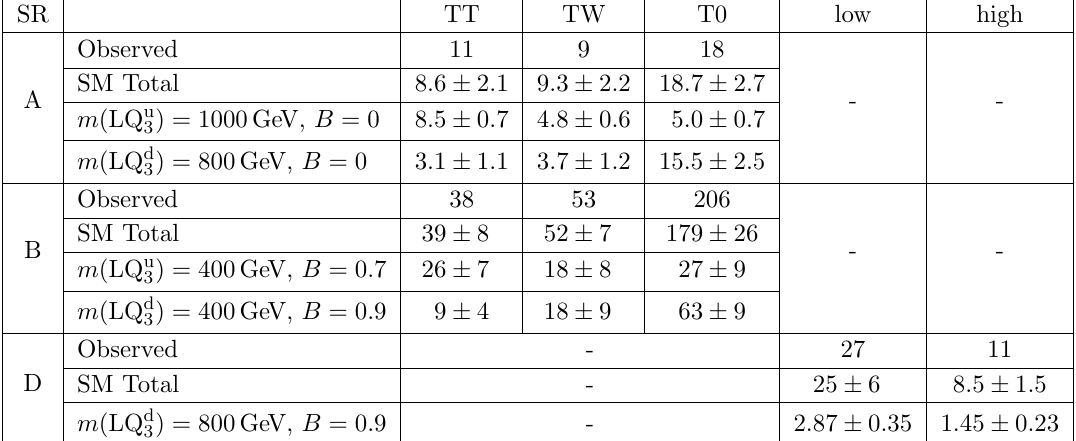
Events are classi(cid:12)ed according to the decay of the (cid:28) -leptons. Both the (cid:28)